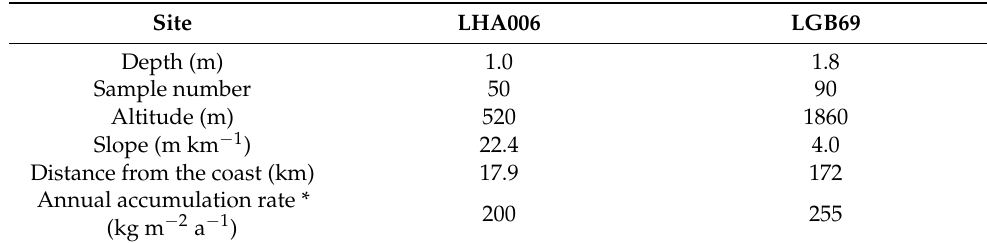
Table 2. Geographical and sampling information of the two snow